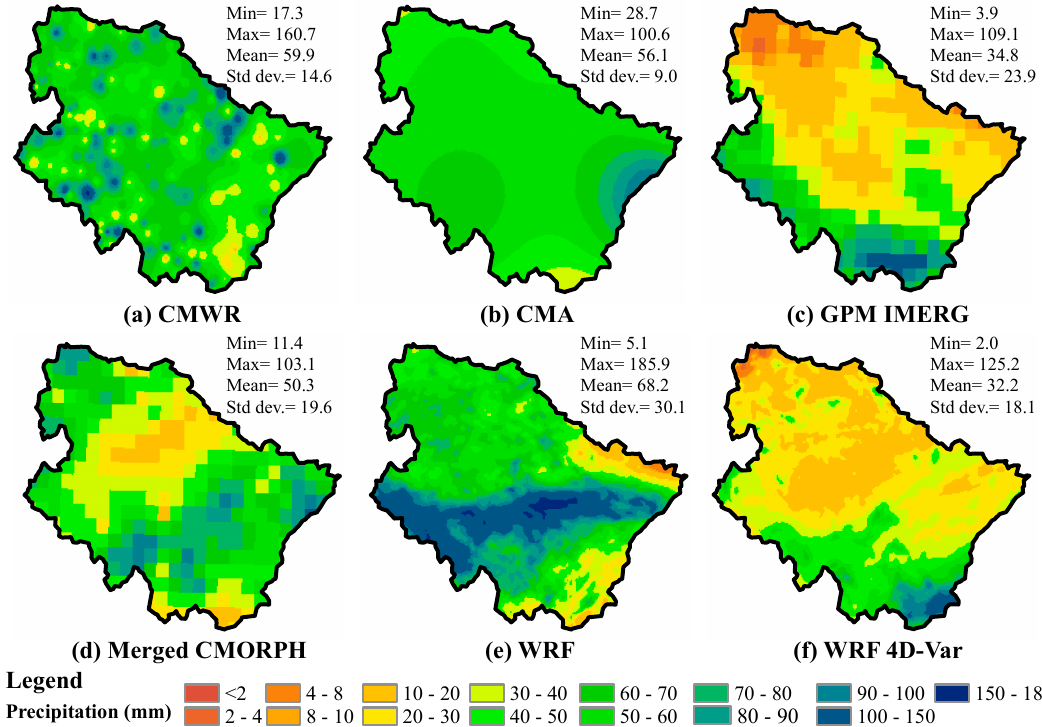
Figure 5. 1-km grid data of the total precipitation (mm) obtained from the precipitation datasets of the CMWR ( a ), CMA ( b ), GPM IMERG ( c ), merged CMORPH ( d ), WRF model ( e ) and WRF 4D-Var system ( f ). The minimum (Min), maximum (Max), mean values and the standard deviation (Std dev.) of the total precipitation are listed in the upper right corner of each graph.